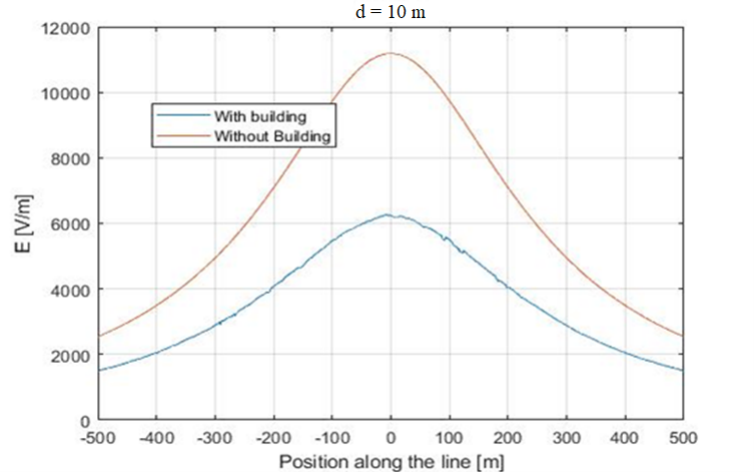
Figure 6. Comparison between the electric field measured along the whole line. (A) H = 20 m, and d varies from 5 to 200 m.